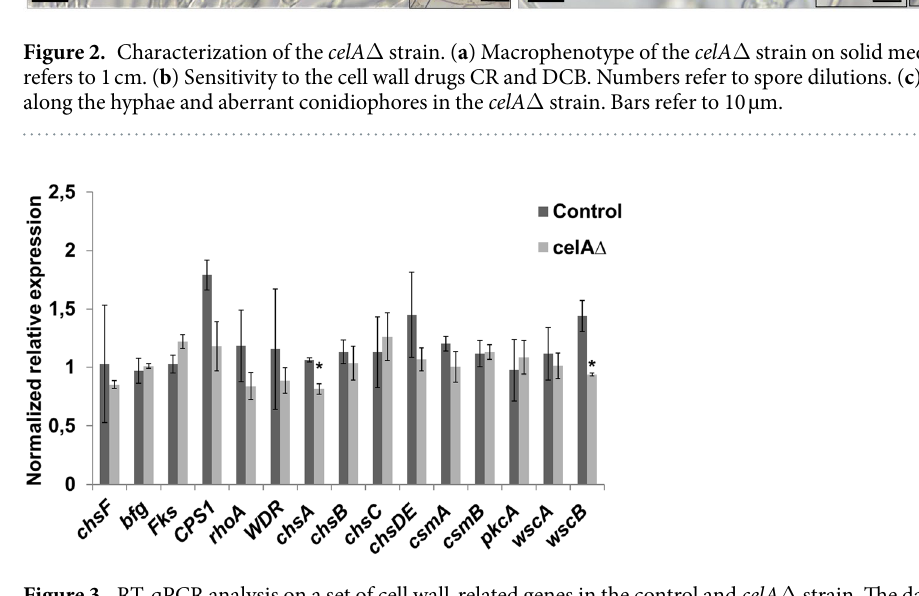
Figure 3. RT-qPCR analysis on a set of cell wall-related genes in the control and celA Δ strain. The data were normalized using rpl3 and CRP2 . Asterisks indicate statistically significant differences ( p <